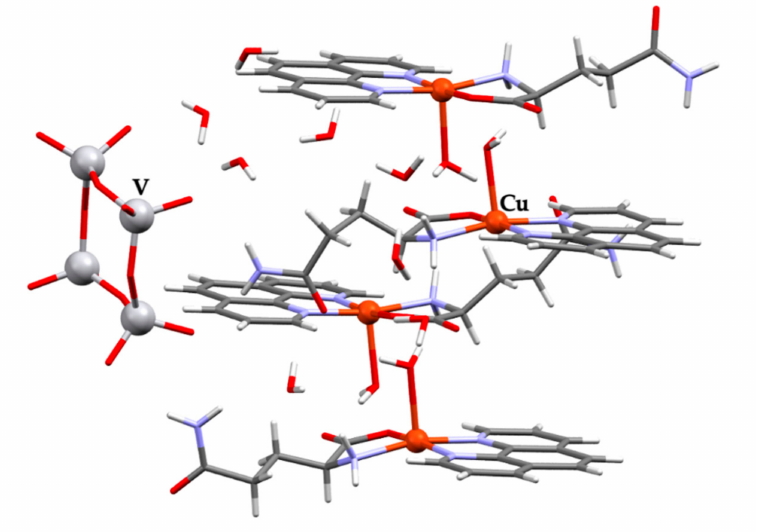
Figure 1. Representation of Compound 1 , where [Cu(L-Gln)(phen)(H 2 O)] + neutralize (V 4 O 12 ) anion. L-glutamine is present as two syn and two anti-conformers, data from [87]. Table 1. Crystal data and structure refinement for Compound 1